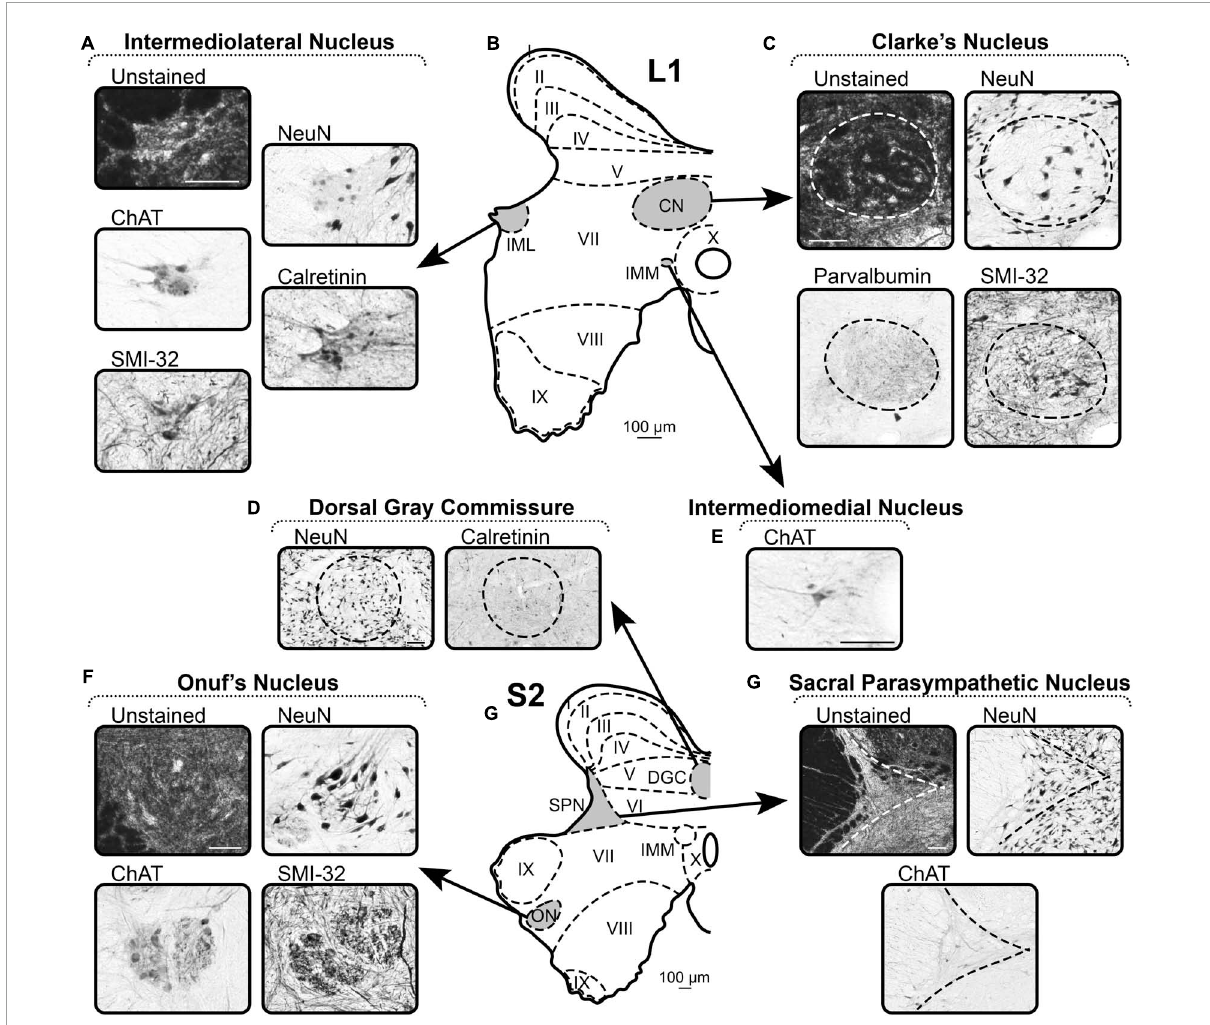
FIGURE6 A representative example of the markers of nuclei of spinal cord. (A–E) Spinal segment L1. (F–H) Spinal segment S2. (A) Distribution of the markers in the Intermediolateral Nucleus. (B) Scheme of L1 segment. (C) Distribution of the markers in the Clarke’s Nucleus. (D) Distribution of the markers in the Dorsal Gray Commissure. (E) Distribution of the markers in the Intermediomedial Nucleus. (F) Distribution of the markers in the Onuf’s Nucleus. (G) Scheme of S2 segment. (H) Distribution of the markers in the Sacral Parasympathetic Nucleus. Scale bar is 100 µ